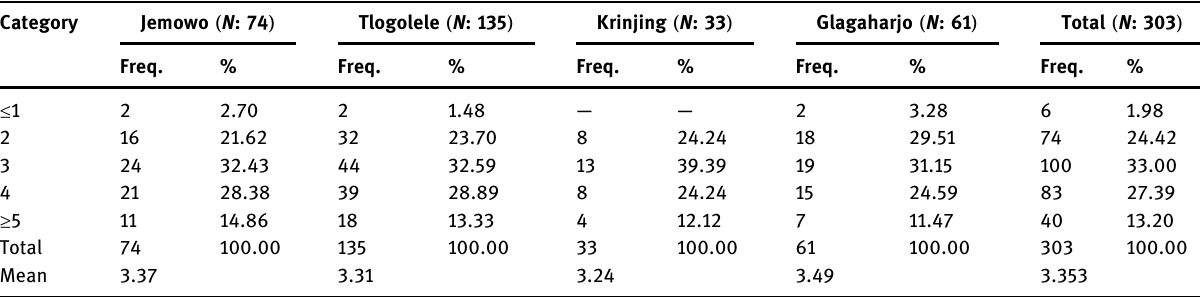
Table 6: Family member of the respondents Category Jemowo ( N : 74 ) Tlogolele ( N : 135 ) Krinjing ( N : 33 ) Glagaharjo ( N : 61 )